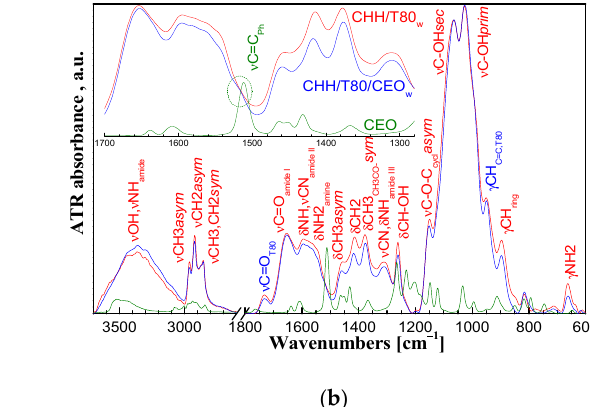
Figure 5. SEM images at the surface and in the cross-section of chitosan-based xerogels at different scales (in the 100–500 μ m range): chitosan–Tween 80 (CHH/T80), CHH//T80 crosslinked with citrate (CHH/T80-Cit), CHH//T80 loaded with clove essential oil (CHH/T80-CEO), and CHH/T80-CEO crosslinked with citrate (CHH/T80-CEO-Cit).